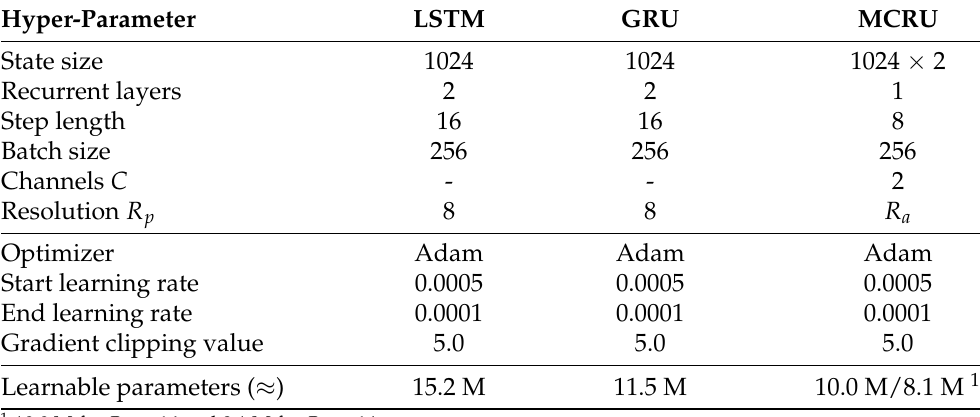
Table 4. Hyper-parameters used in the predictors of dynamic DRCs.